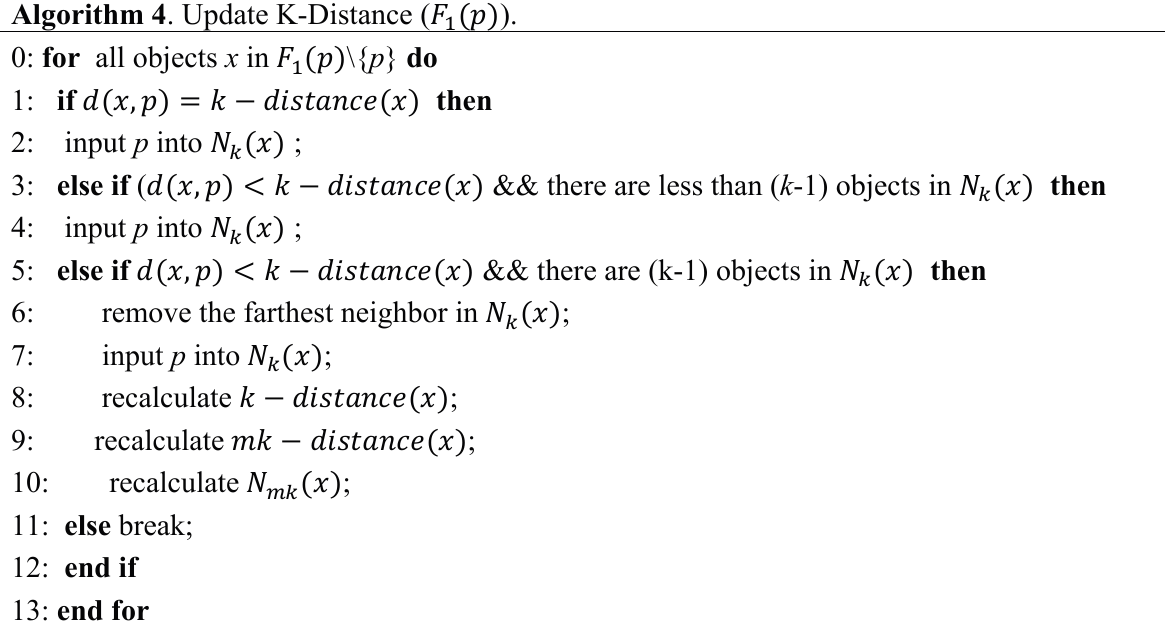
((cid:1868)) (cid:2869)